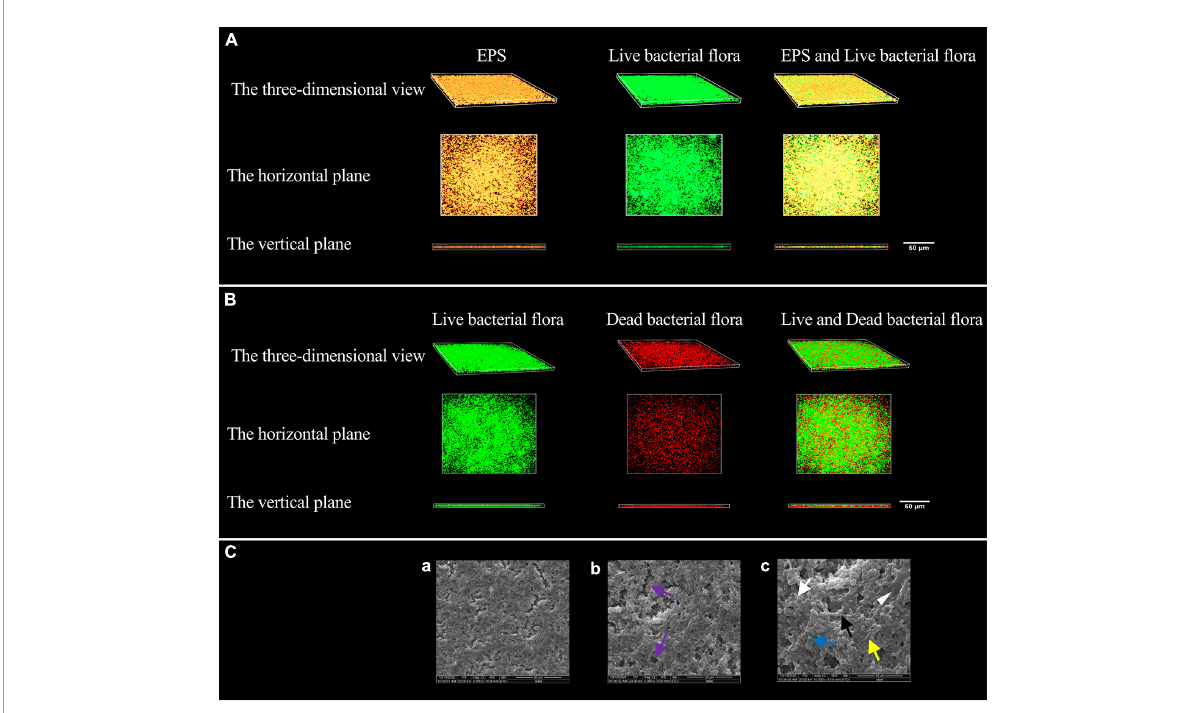
FIGURE1 Modeling results of periodontitis-related microbial multispecies biofilm. (A) The three-dimensional morphology of EPS and live bacterial flora observed by CLSM. (B) The three-dimensional shape of the live and dead bacteria groups observed by CLSM. (C) The SEM observation of the biofilm morphology. (a) × 2000, (b) × 5000, and (c) × 10000. Channel-like structures (purple arrows) are shown in (b) , EPS (white triangle) in (c) , the short rod-shaped bacteria (white arrows) ( Actinomyces viscosus ), the paired ball-shaped bacteria (black arrows) ( Aggregatibacter actinomycetemcomitans ), the small spherical bacteria (blue arrow) ( Porphyromonas gingivalis ), and the bacteria arranged in short chains (yellow arrow) ( F. nucleatum subsp. polymorpha ) are shown in (c)